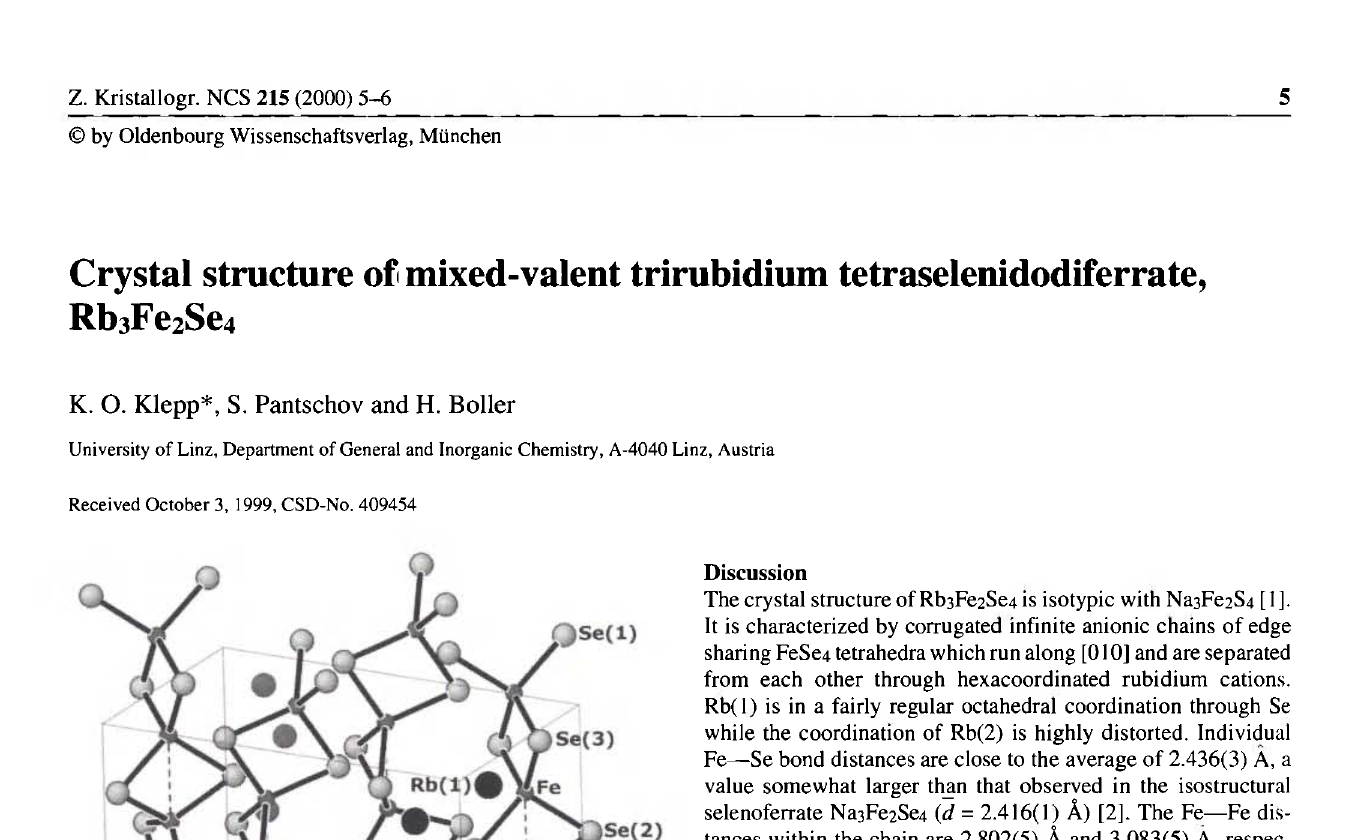
Table 1. Data collection and